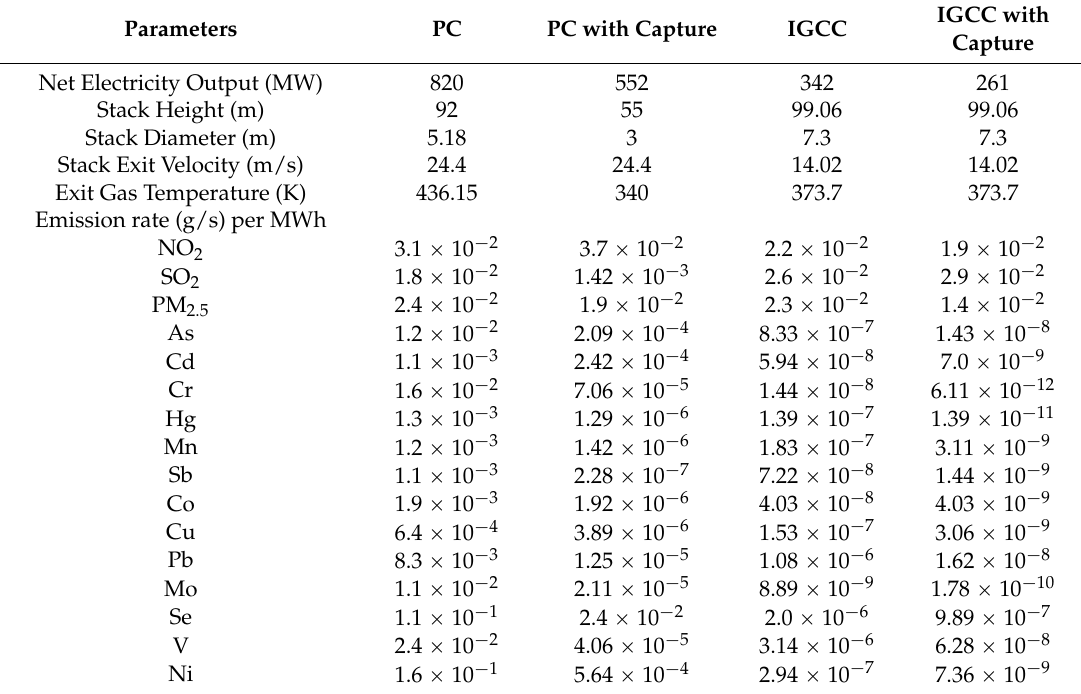
Table 3. Emission rates and stack parameters for